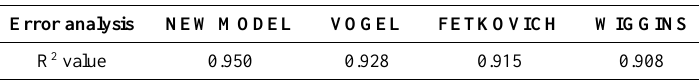
Table 2. Statistical analysis of results obtained for reservoir 2